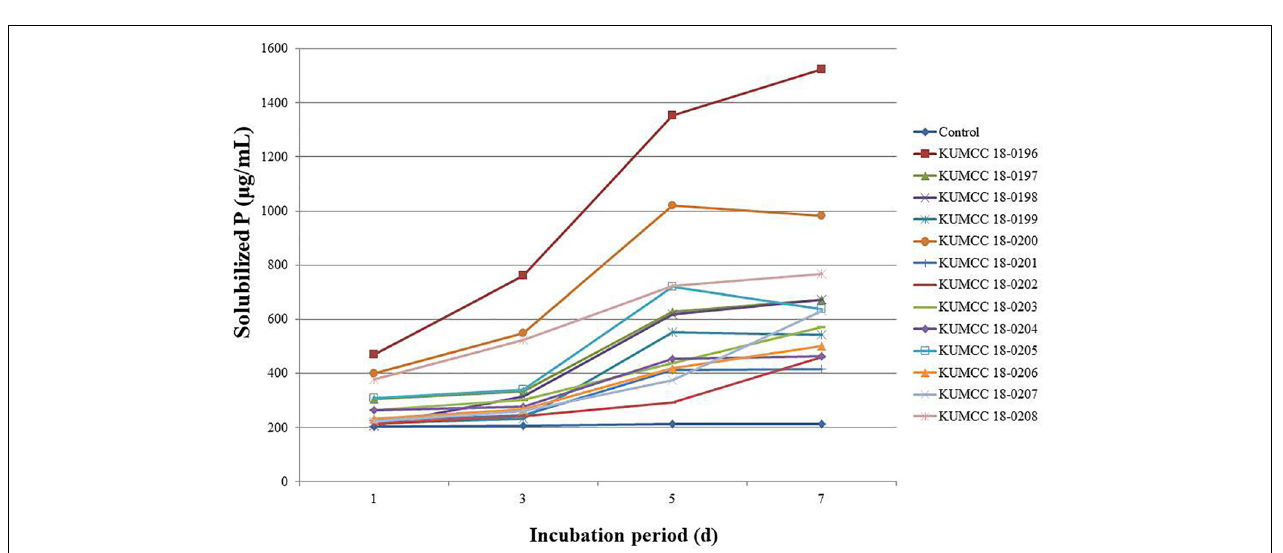
FIGURE 2 | Solubilization index (SI) of 13 fungal strains and control on PVK agar containing TCP after the 1 st , 3 rd , 5 th , and 7 th day of incubation (each value represents the mean of the three replicates).